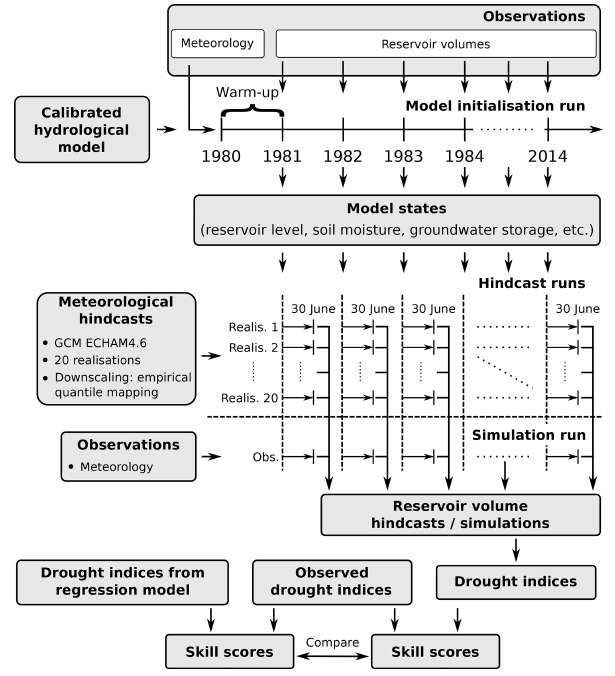
Figure 2. Workflow for the generation and evaluation of hindcasts of hydrological drought